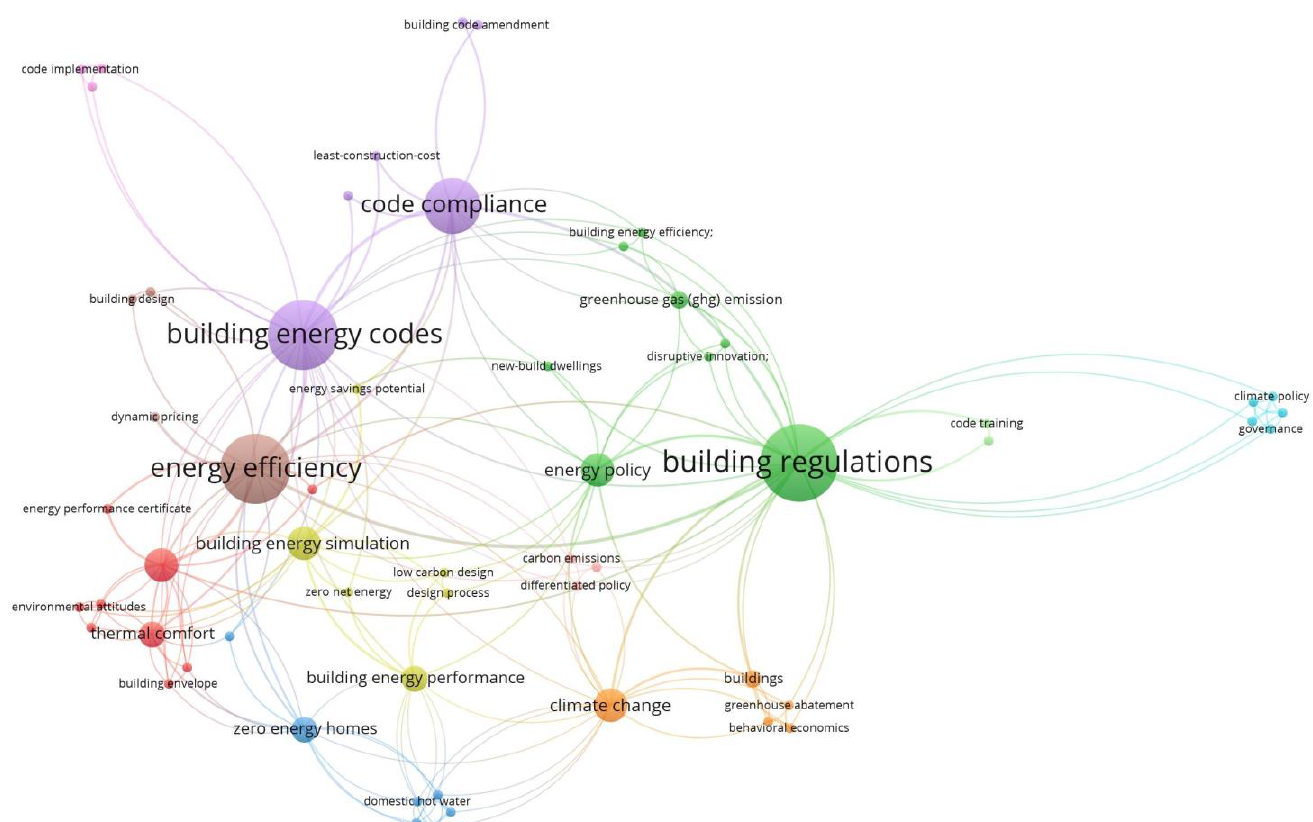
Figure 3. Keyword co-occurrence map (lines indicate relationships among keywords (i.e., co-occurrence), and nodes’ sizes represent frequency of keyword -occurrence).